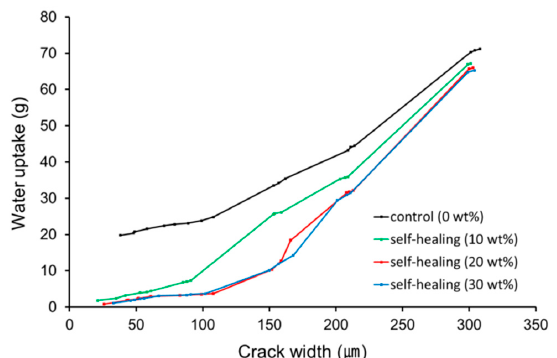
Figure 5. ( a ) Water uptake versus capsule loading of the coated mortar specimens. A scratch was applied on the surface of each coating at a width of 30 or 90 μ m; ( b ) Healing efficiency versus capsule loading of the self-healing coating calculated using Equation (2) and the data shown in ( a ).